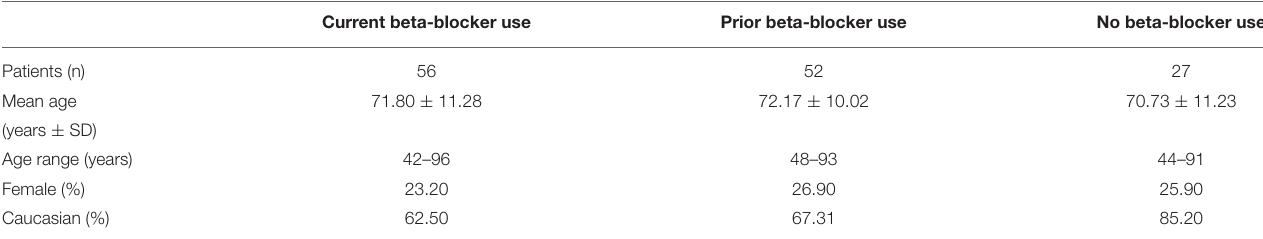
TABLE 1 | Demographic data by beta blocker use